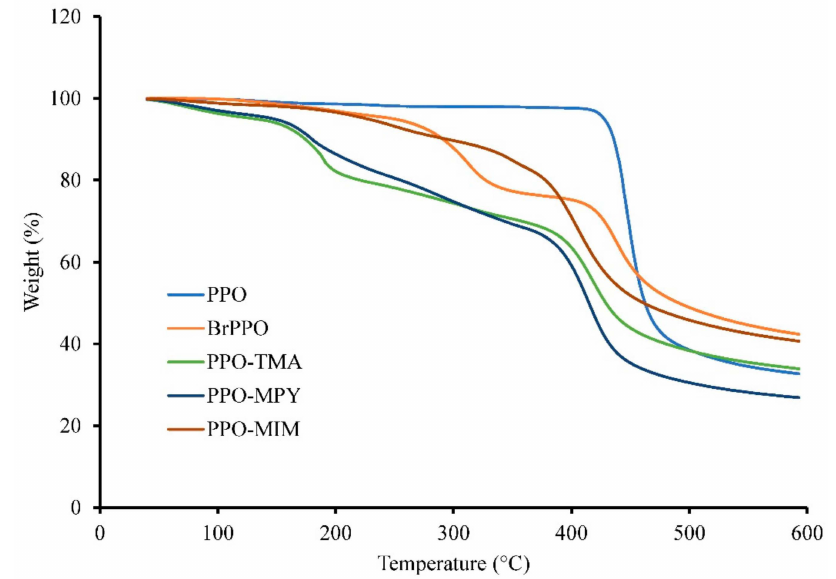
Figure 4. TGA curves of PPO, BrPPO, PPO–TMA, PPO–MPY, and